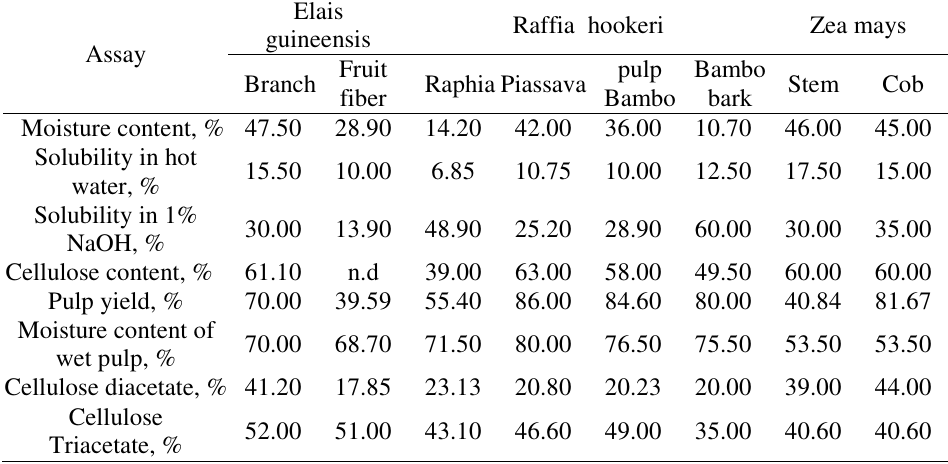
Table 1 . Proximate Composition and Acetate Yield of Some Agricultural Waste